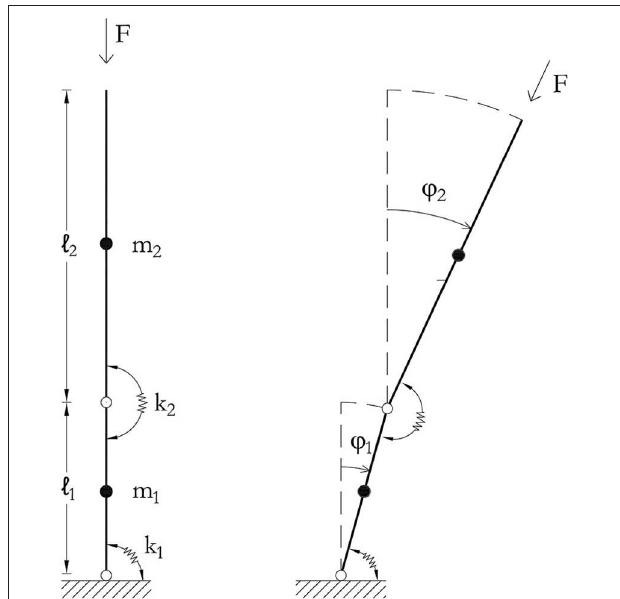
FIGURE 7 | The Ziegler double